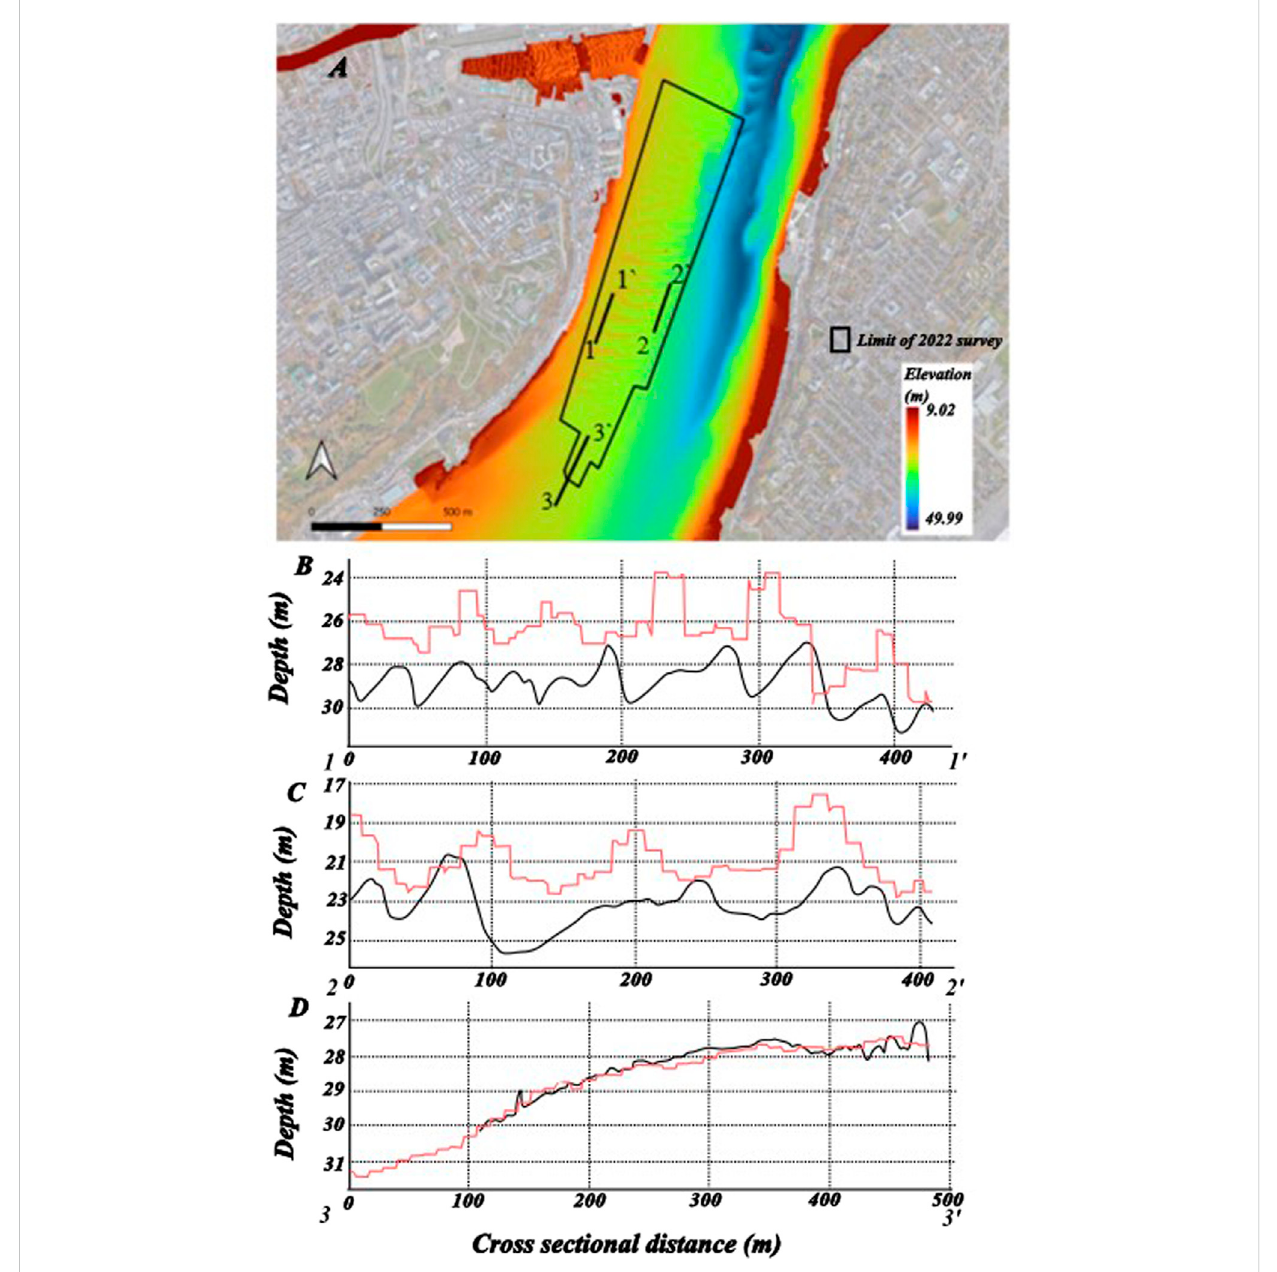
FIGURE 10 In (A) , thecombined multisource DBMgenerated with historical and July 2022 datasets. In (B – D) thecross-sectional pro fi les of thecombined DBM with NONNA data in red and the July 2022 data display the signi fi cant differences in the existing and historical dataset while maintaining a continuity between the data